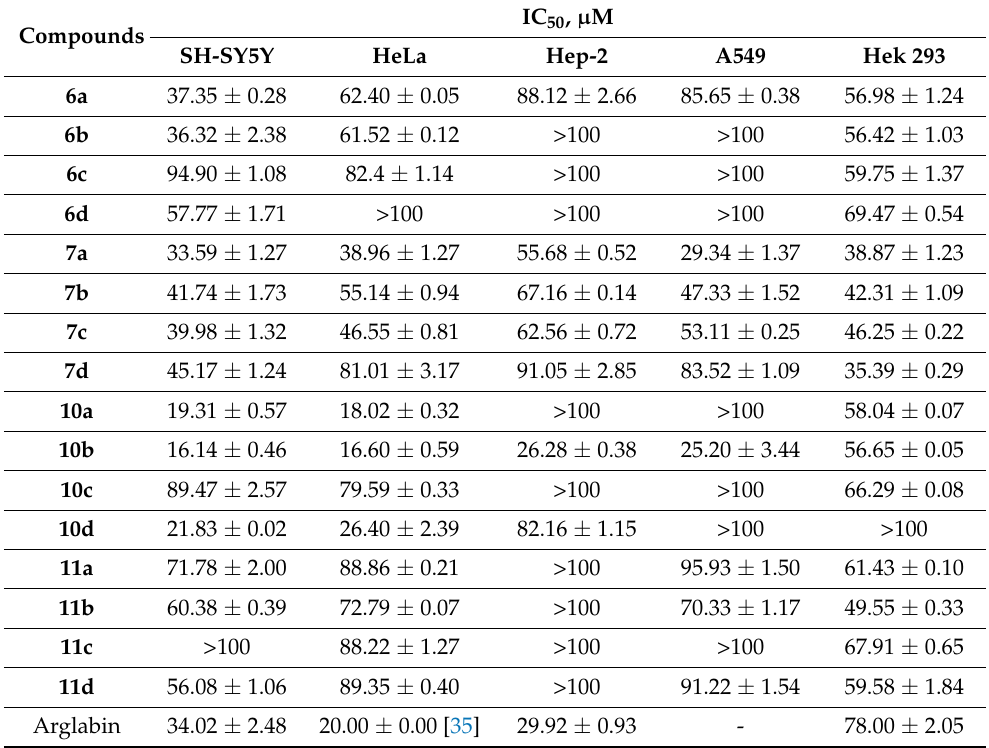
Table 1. Cytotoxic potential of dehydrocostuslactone and alantolactone conjugates with alkoxy- substituted benzyl